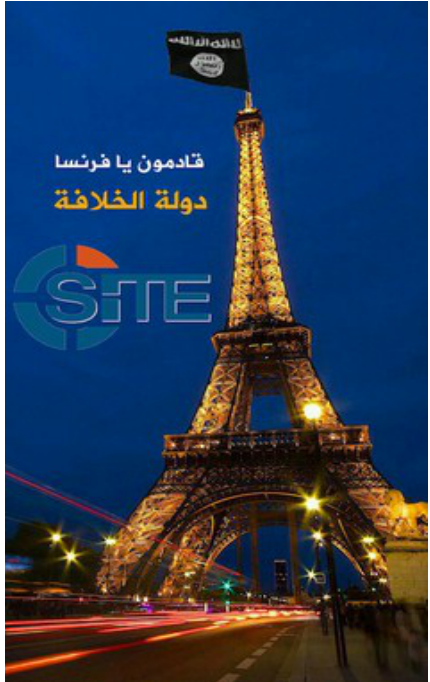
Figure 2. The Eiffel Tower redesigned as a triumphal arch with Da’esh’s flag flying victoriously on top.